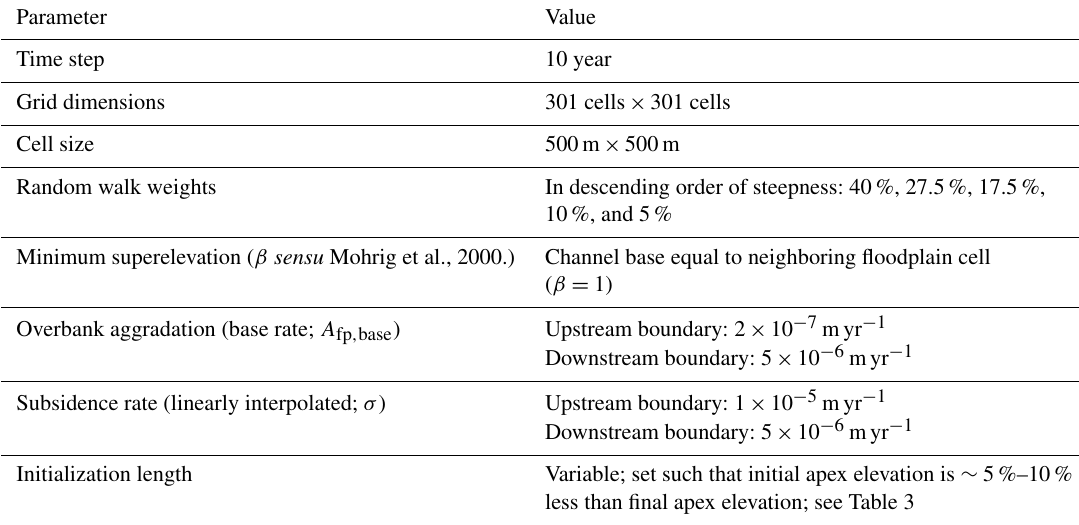
Table 1. Cellular model parameters. Values for parameters were chosen to be representative of rivers commonly found atop megafans in mountain-front regions, including those seen in Fig. 1.